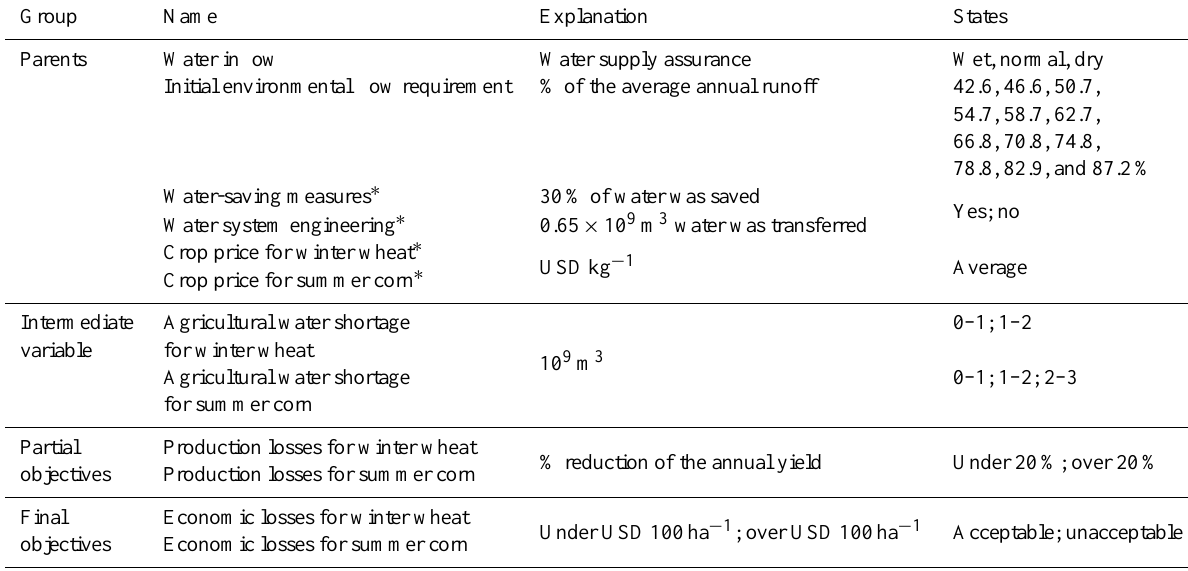
Table 1. Nodes and outputs in the TOBNs.